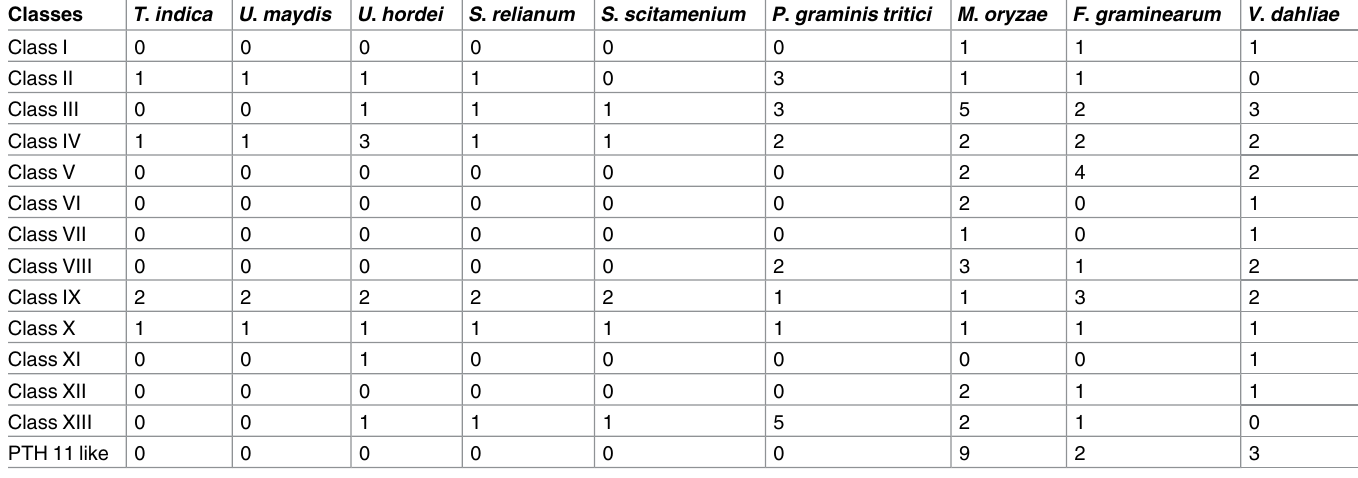
Table 3. GPCR in different fungal genomes *